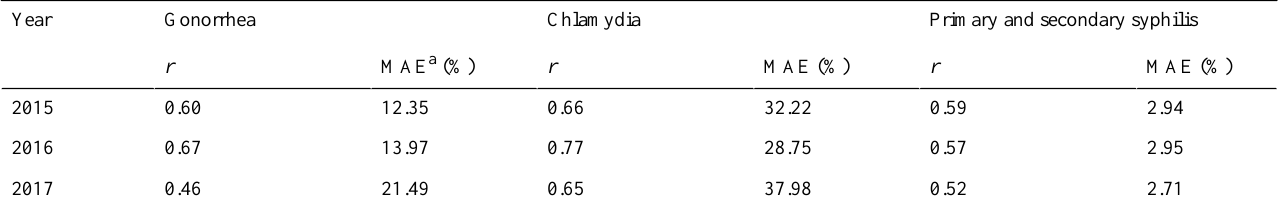
Table 7. Correlations between actual and predicted cases of STIs for 2015-2017. P <.001 for all r